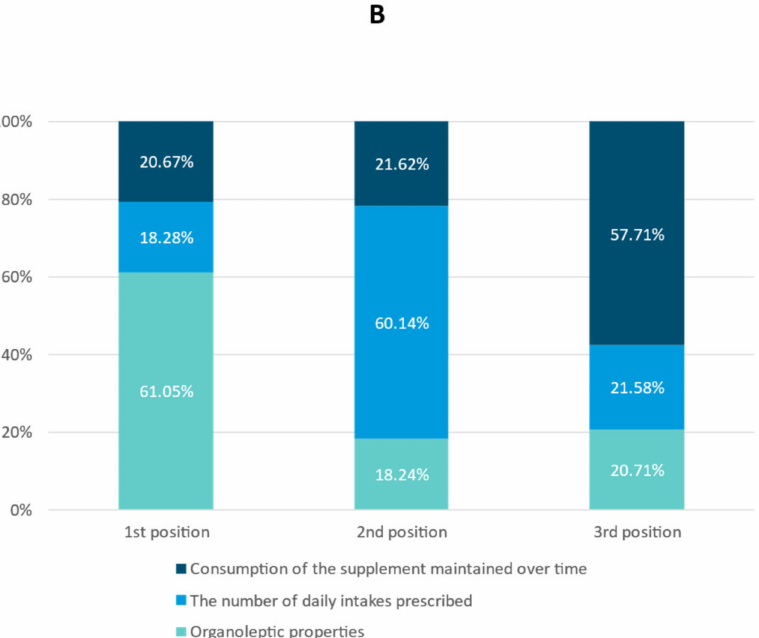
Figure 2. ( A ) Which of these organoleptic properties: smell, flavor or texture, has the most influence on adherence to the nutritional supplement? ( B ) Which of these options: organoleptic properties, the number of daily intakes prescribed or the consumption of the supplement maintained over time, has influenced ONS adherence most positively?